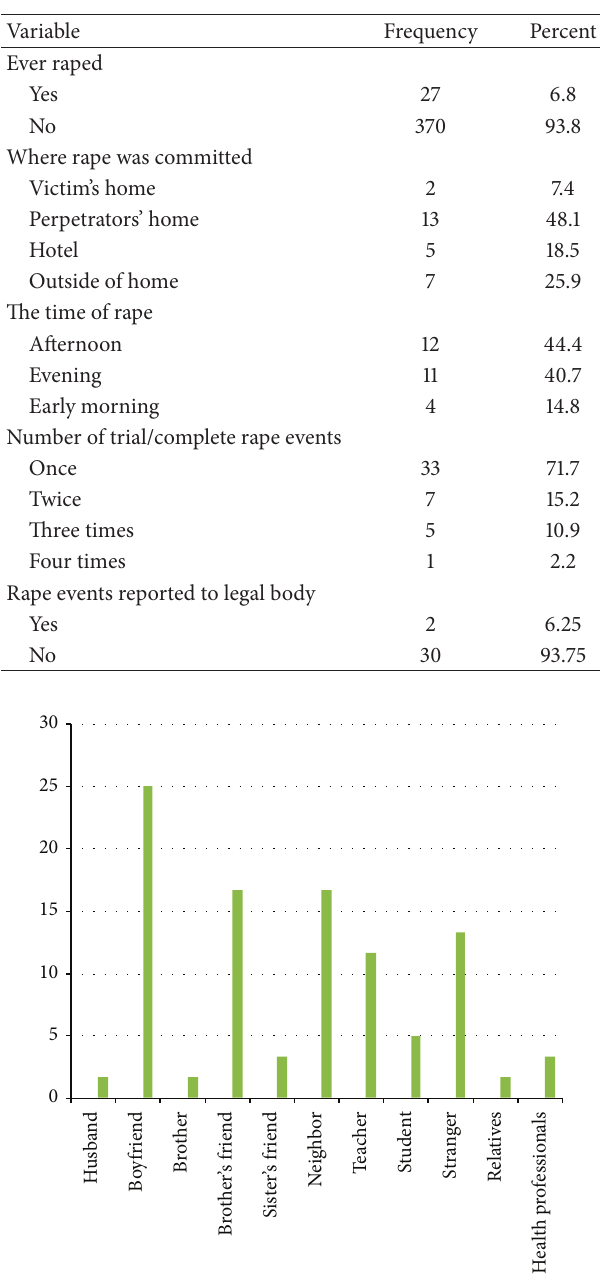
Table 4: Ever raped, where rape was committed, time of rape event, number of rape events, and reporting rape to legal body, Madawalabu University, May 2012.